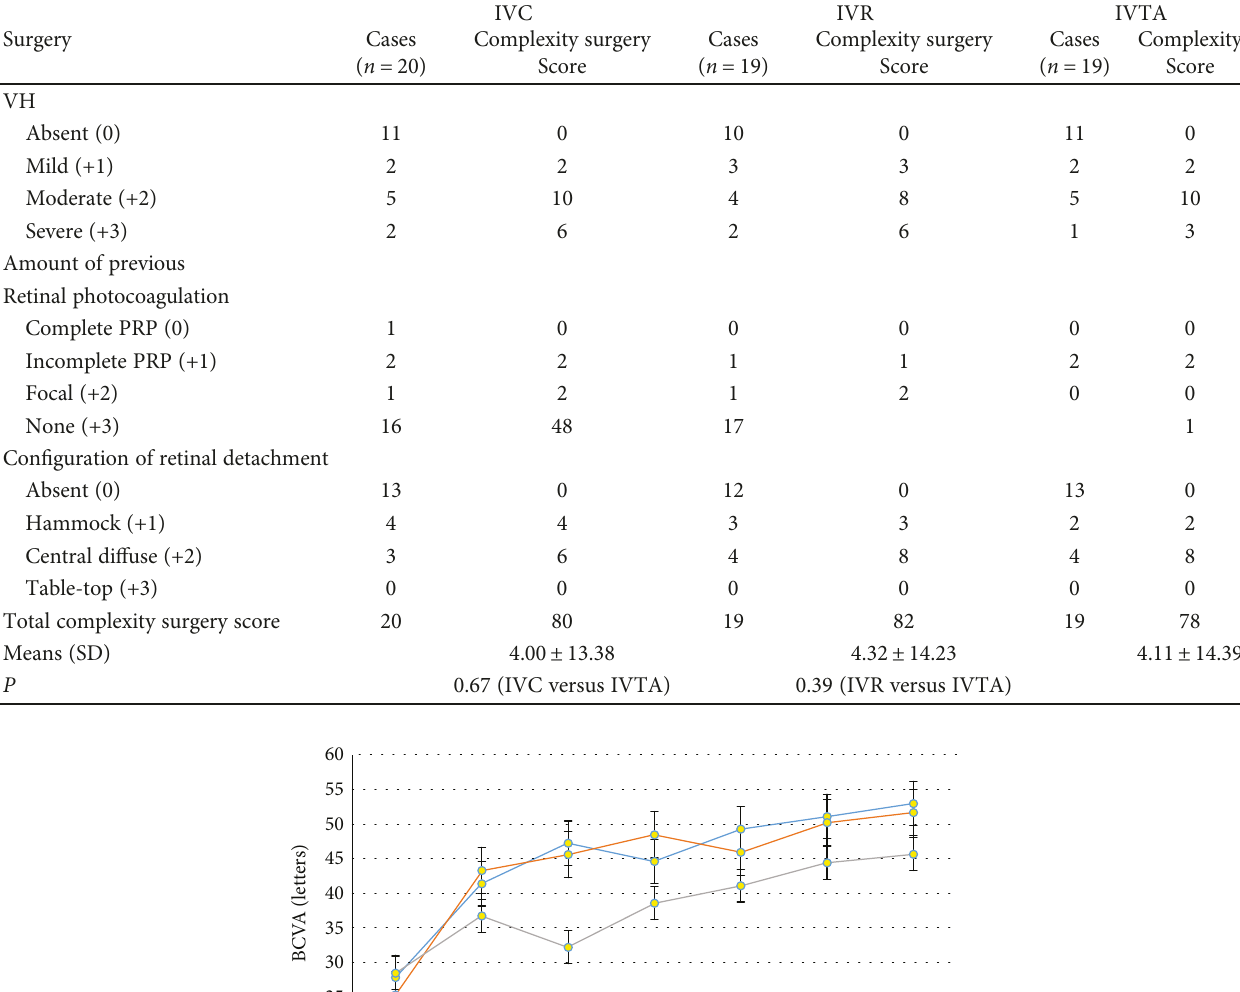
Table 2: Baseline complexity surgery score of DR patients.